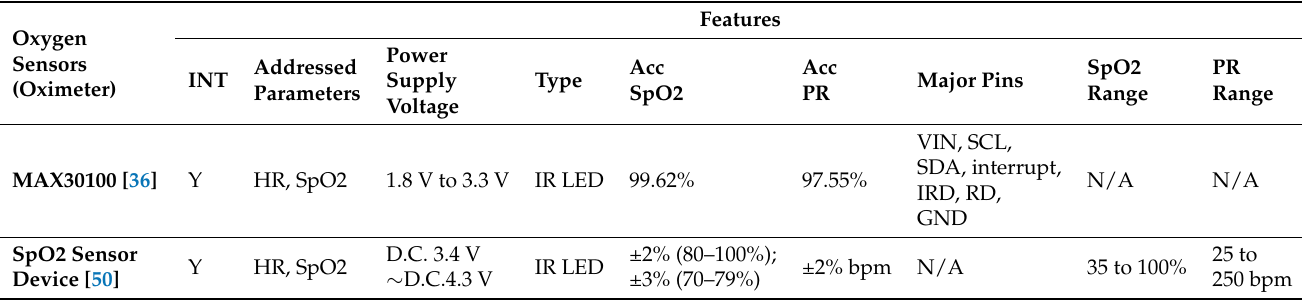
Table 8. Features of oxygen sensors/devices.